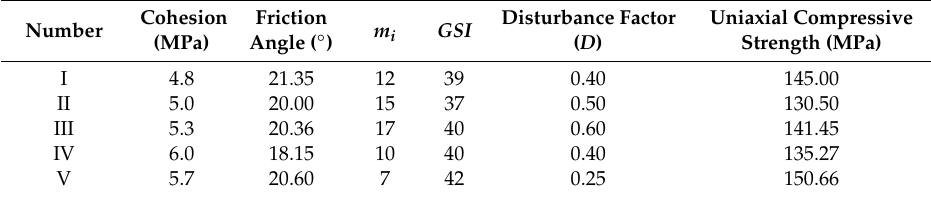
Table 4. Physical and mechanical parameters for Mohr–Coulomb and Hoek–Brown